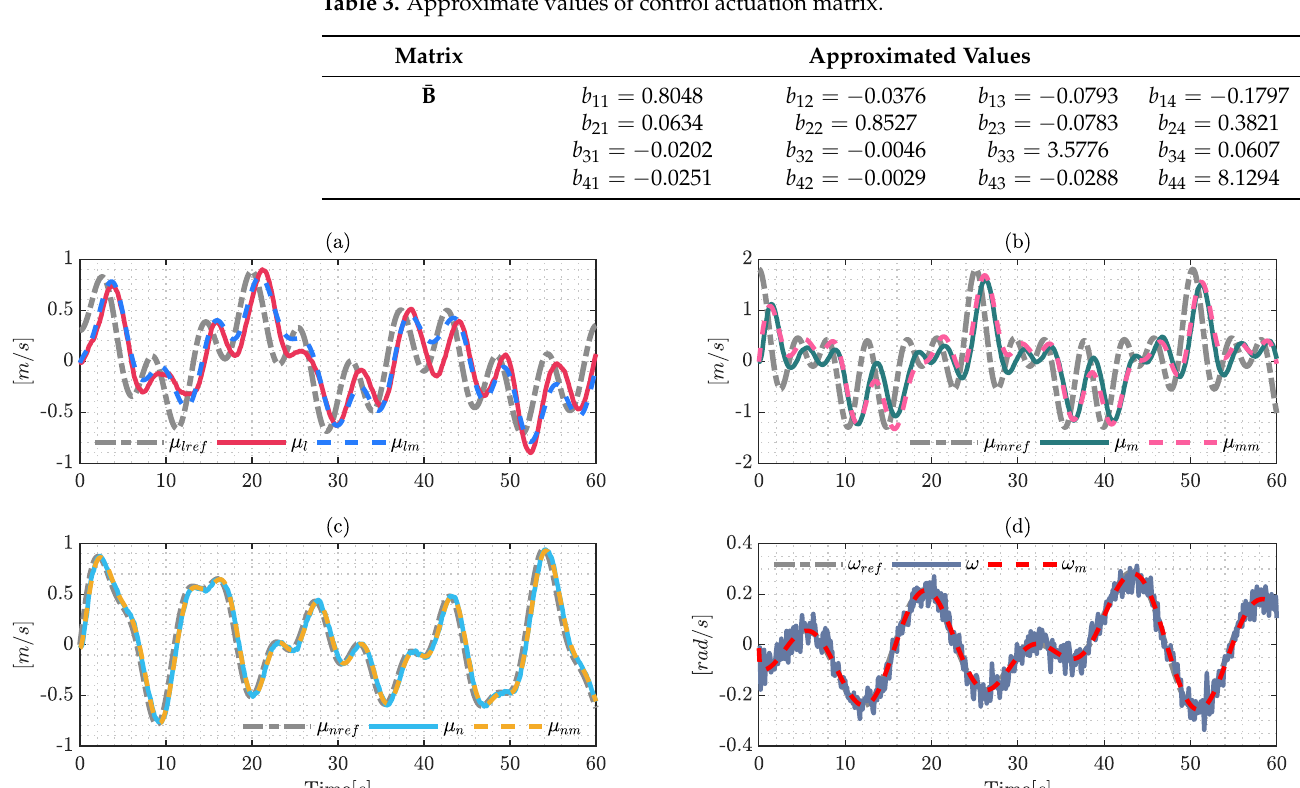
Table 3. Approximate values of control actuation matrix.